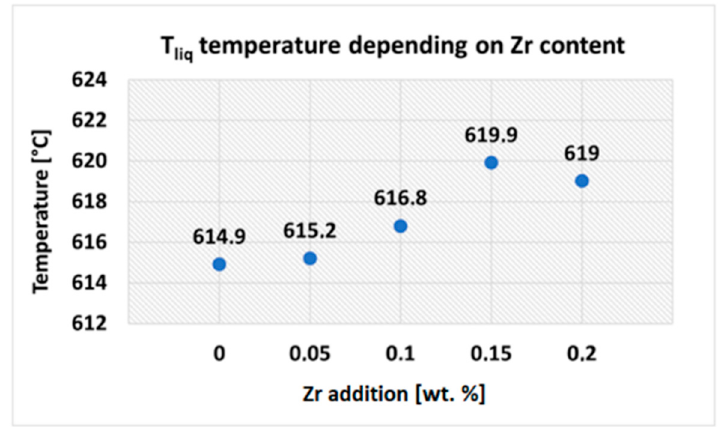
Figure 4. Liquidus temperature depending on Zr addition .